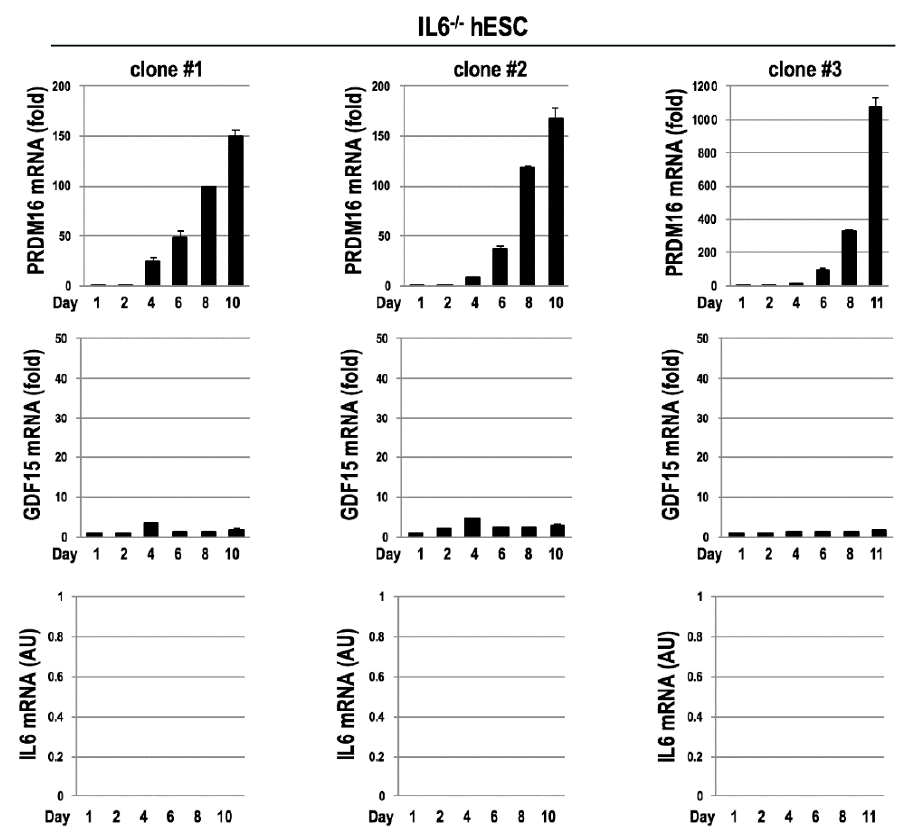
Commented [m4]: Please add the explanation of “**” in Figure 5a. Commented [KS5R4]: I deleted “**”, which means P < 0.01, because the P value was described on the graph.